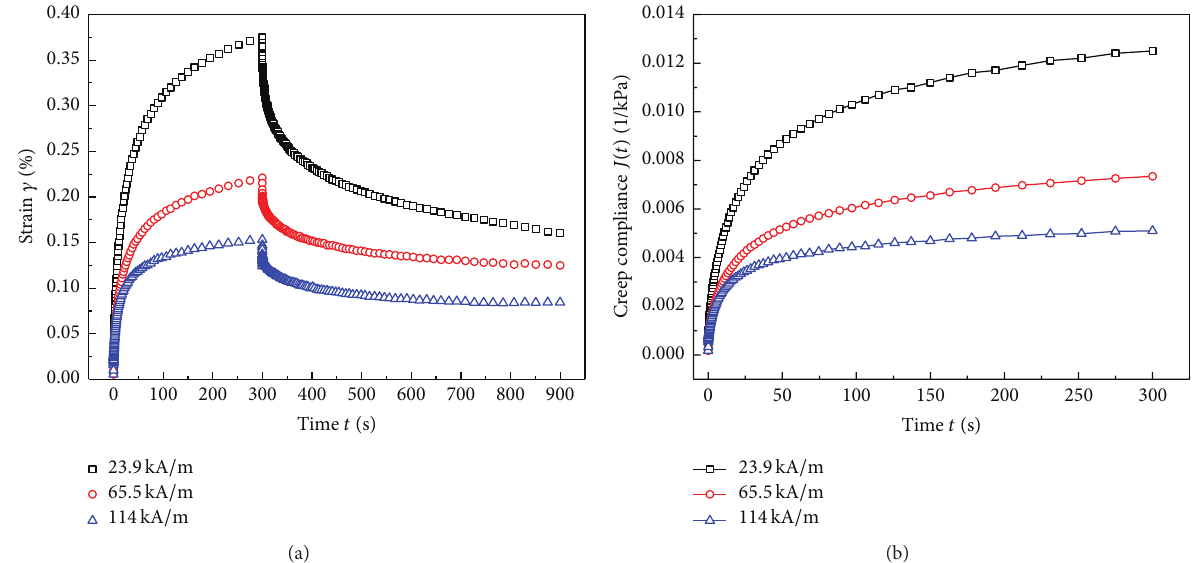
Figure 3: The creep characteristic of MRSP-4 on the condition of different external magnetic field strength and the same initial stress 300 Pa: (a) creep and recovery phase and (b) creep compliance in creep phase.